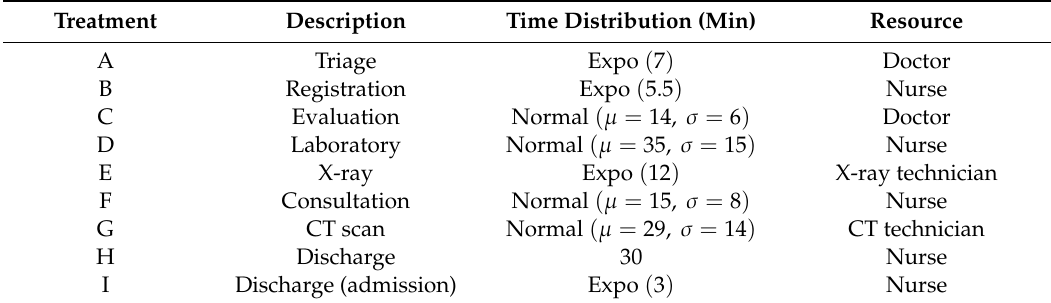
Table 2. Time distribution of